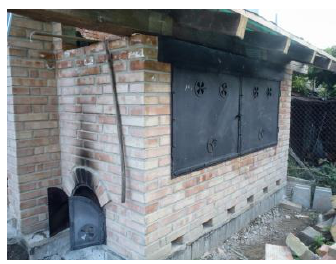
Figure 7a. Apple slices drying on the sun